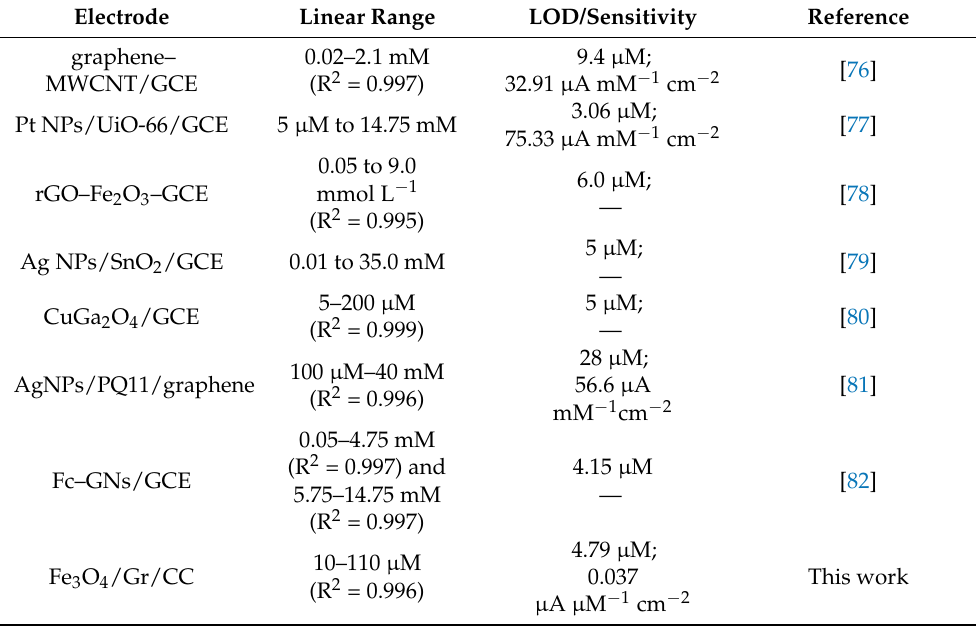
Table 2. Comparison of sensing performance of some reported peroxide sensors with the present work.